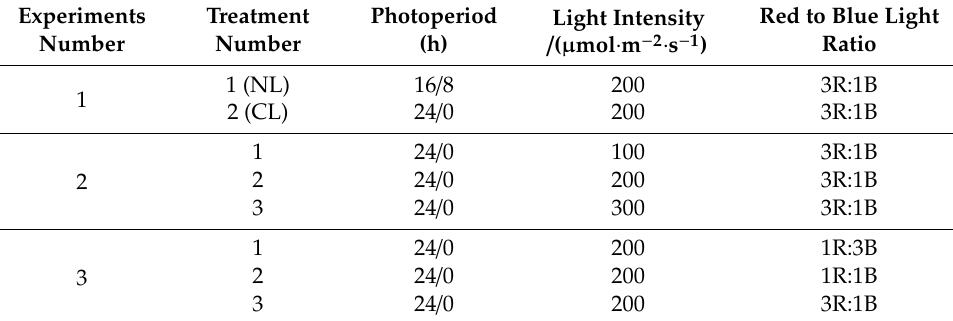
Table 1. The details of light treatments for three experiments.